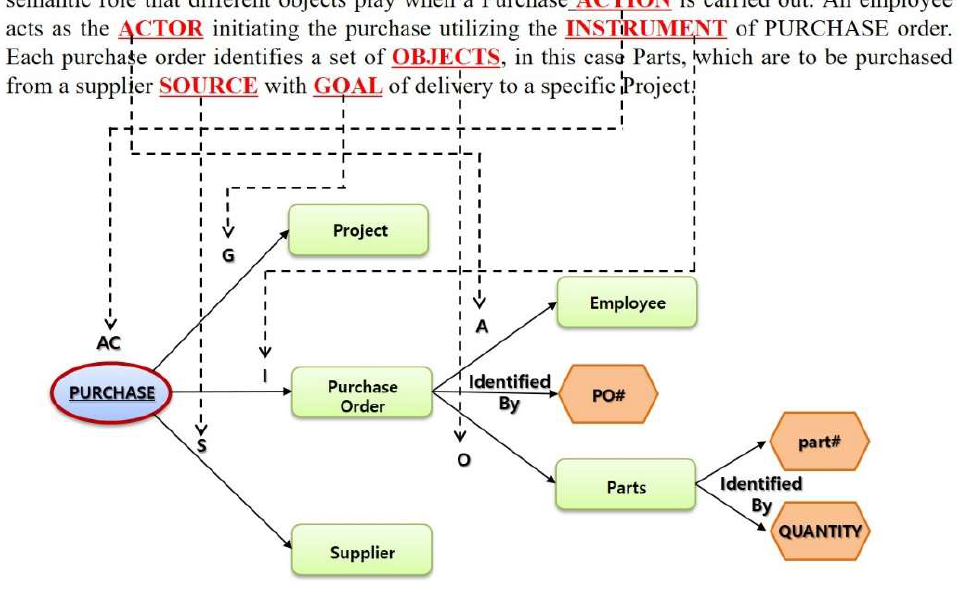
Figure 4. Visual modeling example.